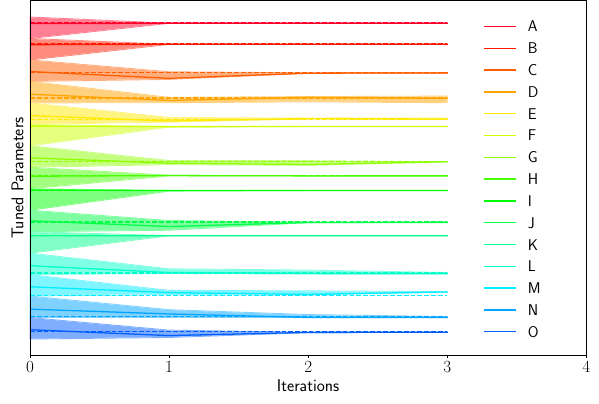
Fig. 4 Iterated tuning to polynomial pseudo data using the Autotunes method